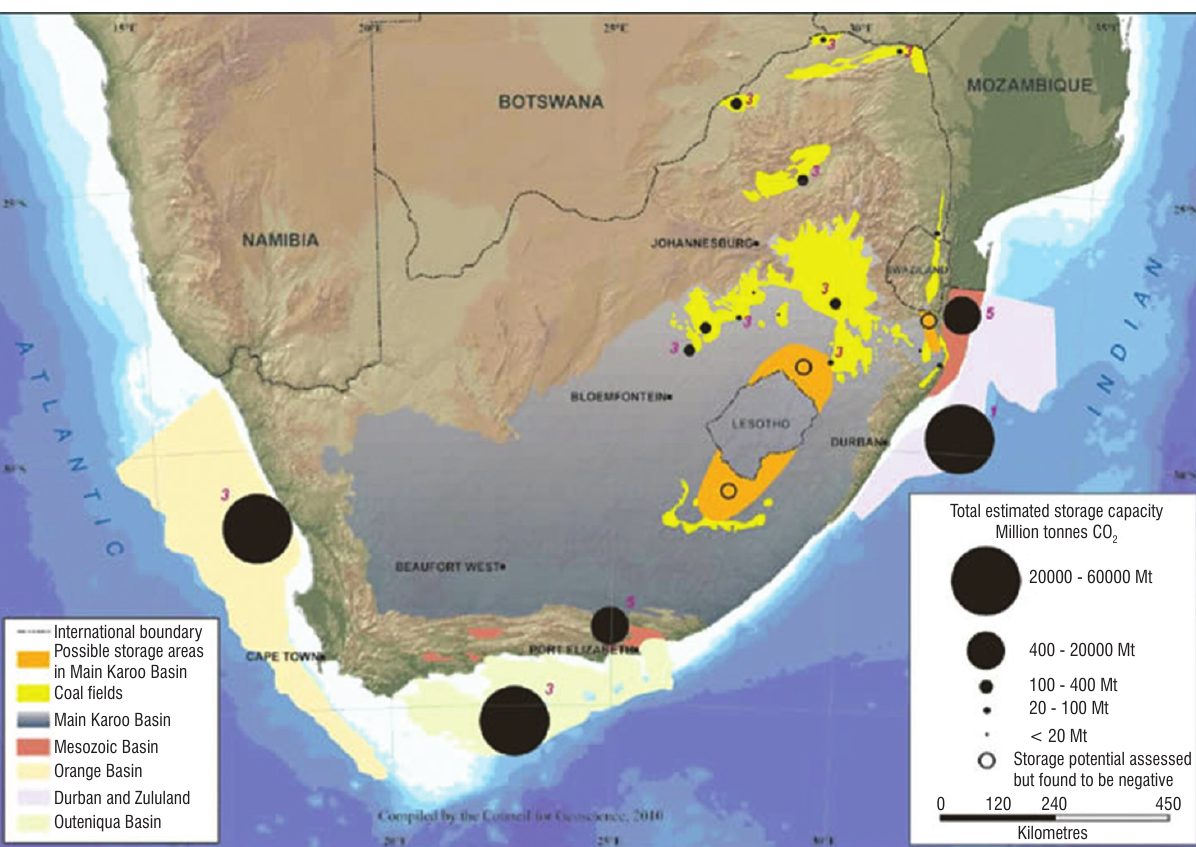
storage in South Africa. 2